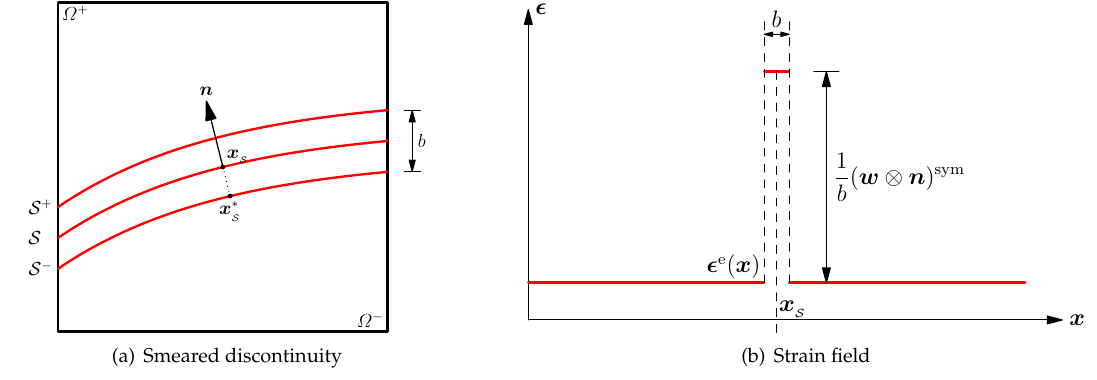
Figure B1. Smeared discontinuity and the resulting discontinuous strain field in an elastic